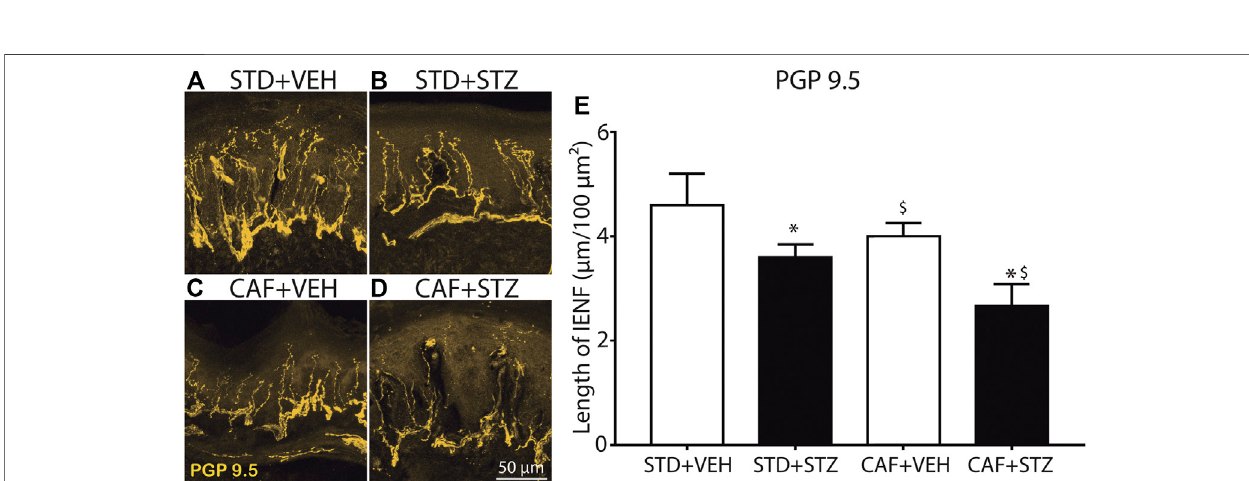
FIGURE 5 | Loss of epidermal nerve fi bers in footpads of female mice with diabetes induced by cafeteria diet and low doses of STZ. Representative confocal images of intraepidermal PGP-9.5 immunopositive nerve fi bers from the glabrous skin of the hindpaw, obtained from STD + VEH mice (A) STD + STZ mice (B) CAF + VEH (C) ,andCAF+STZ (D) . (E) Quanti fi cationoftheIENFineach experimental condition.Valuesaremeans ± SEM(n (cid:1) 6).* p < 0.05forCAF[F (1,18) (cid:1) 5.45],$( p < 0.05) forSTZ[F (1,18) (cid:1) 9.14],theinteractionCAF × STZdidnotreachstatisticalsigni fi cance,*and$ontheCAF × STZcolumnrepresenttheseparateeffectofeachfactor on the PGP-9.5 nerve length. Two-Way ANOVA.